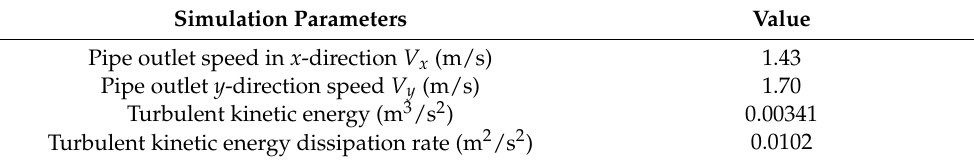
Table 1. Simulation